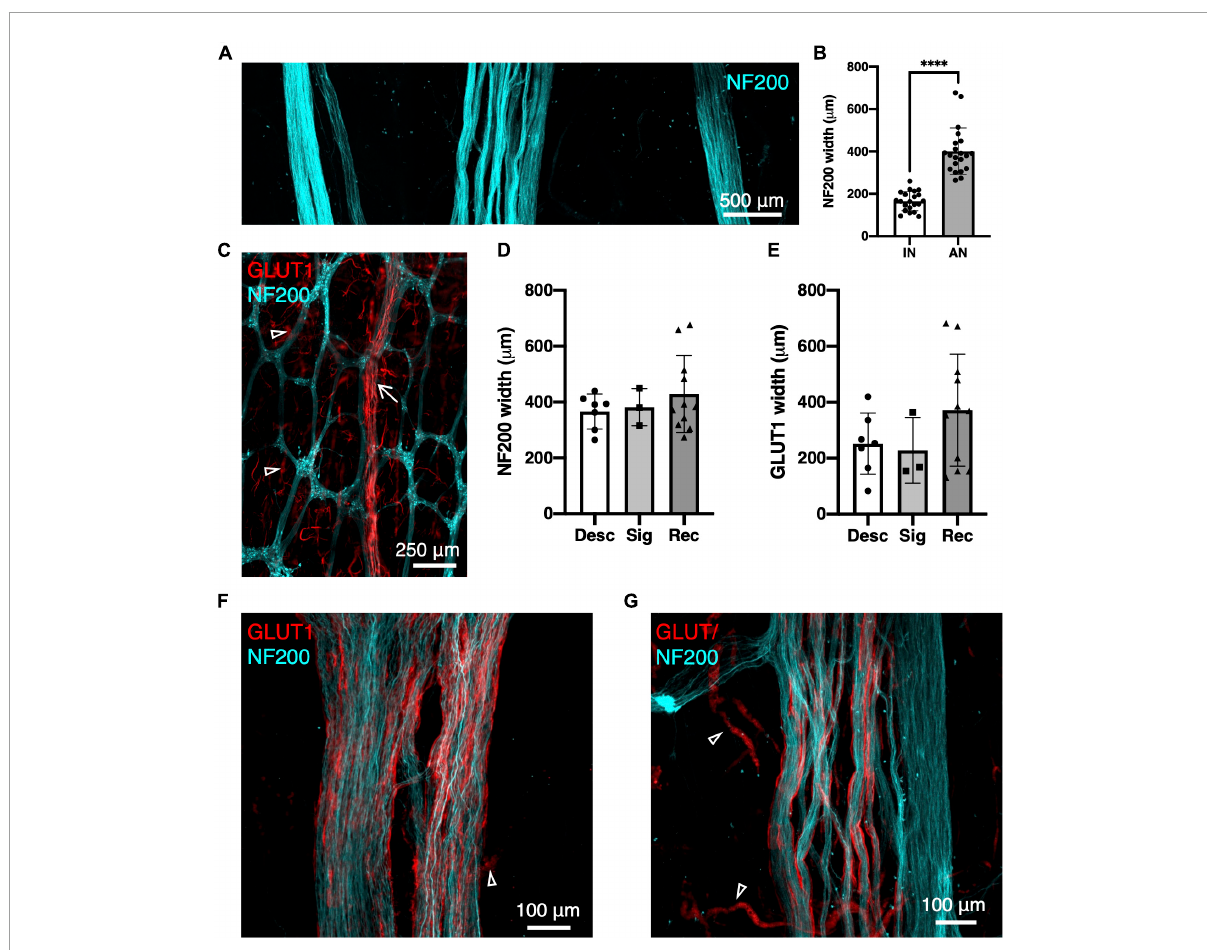
FIGURE1 Ascending nerves labelled with neurofilament-H (NF200; cyan) and glucose transporter 1 (GLUT1; red) in human colon. (A) An ascending nerve (middle) is wider and has several rope-like strands, compared to two internodal strands of the myenteric plexus (left and right). (B) Summarised data for widths of 21 internodal strands (IN, n = 7 patients) and 21 ascending nerves (AN, n = 7), **** p < 0.0001. (C) Low power image of myenteric plexus with enteric neurons labelled with NF200 and an ascending nerve (arrow) running longitudinally, mostly independently of ganglia. (D,E) Widths of ascending nerves did not differ significantly between descending colon (Desc), sigmoid colon (Sig), and rectosigmoid/rectum (Rec) when measured from NF200 labelling of axons (D) or GLUT1 labelling of perineurial sheaths (E) . Panel (F) shows an ascending nerve in rectum which has GLUT1 immunoreactive perineurial staining across its full width. (G) More proximally, in descending colon the perineurial sheath is restricted to the left; on the right is an enteric internodal strand running parallel, which lacks GLUT1. Fragmented GLUT1 (open arrowheads) is labelling of red blood cells in small vessels.